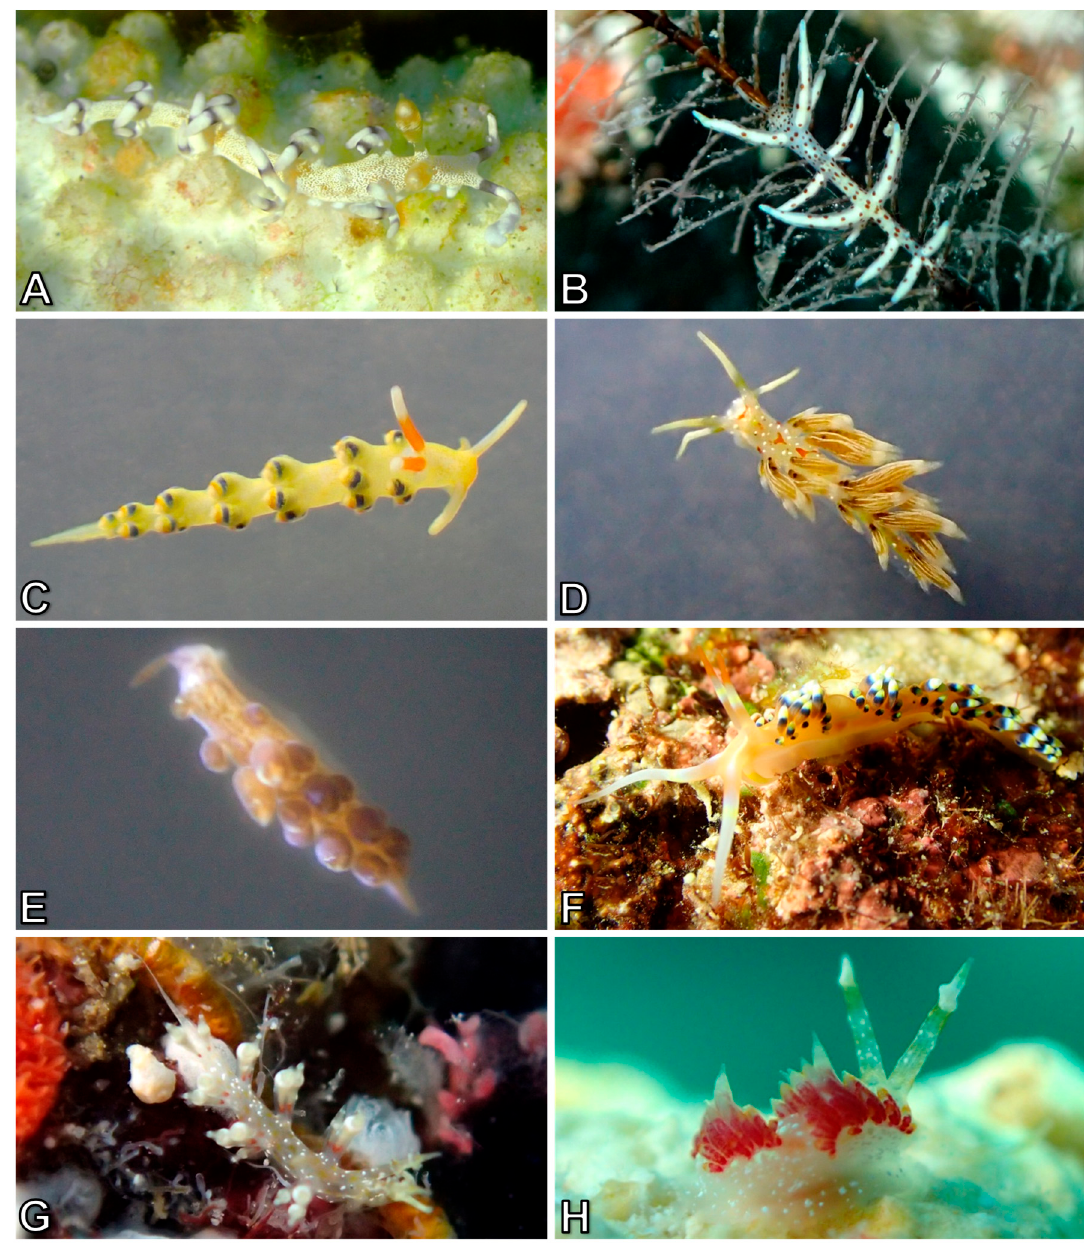
Figure 14. Nudibranchia - Cladobranchia: ( A ) Samla riwo ; ( B ) Eubranchus spec. ( Eubranchus sp. 22 in Gosliner et al. [11]: 341), Eusp22_16Bu-1; ( C ) Cuthona spec. ( Cuthona sp. 4 in Gosliner et al. [11]: 343), Cusp4_16Bu-1;